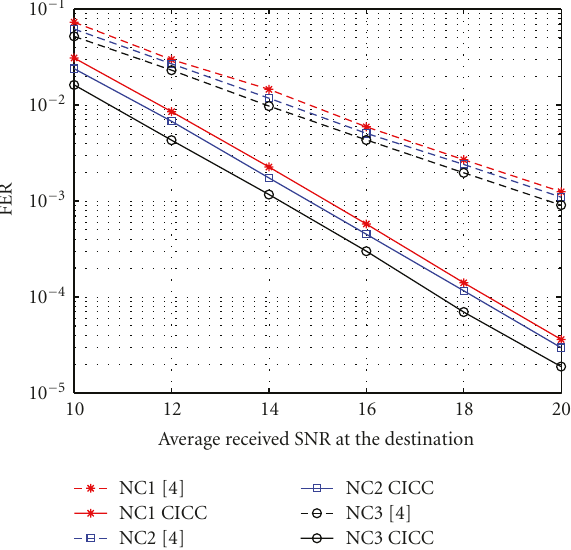
Figure 12: Occurrence percentages of C1 for QPSK codes.